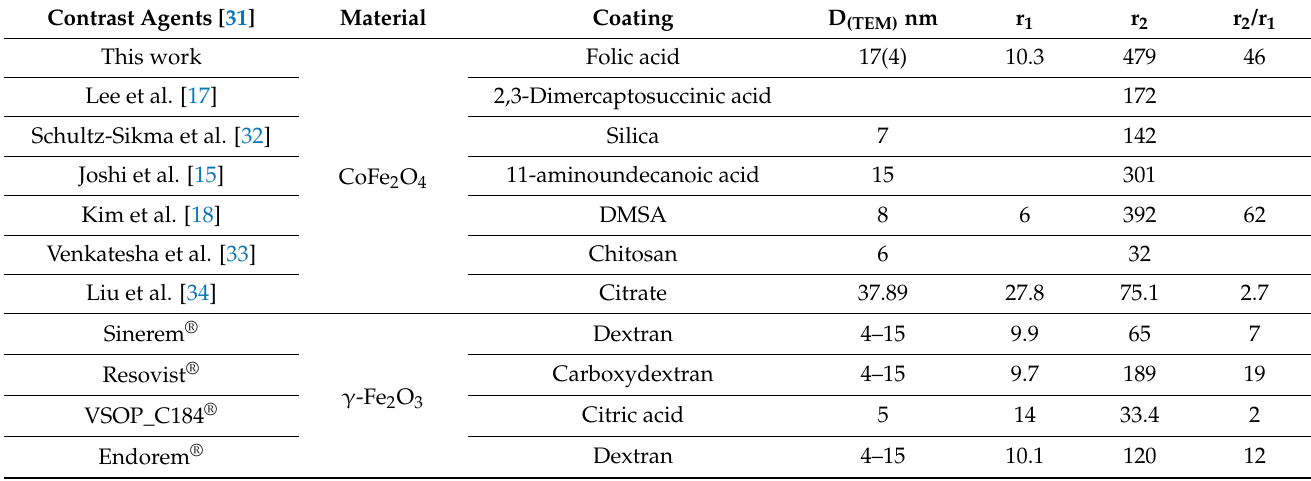
Figure 4. ( a ) T 1 and T 2 inverse measurements vs. cobalt and iron millimolar concentration. The slope of these curves corresponds to r 1 and r 2 relaxivities. ( b ) T 2 -weigthed magnetic resonance (MR) images of NP-FA in aqueous solution at various metal concentrations using a Varian 7T micro magnetic resonance imaging (MRI) scanner. Table 1. Relaxivity collection values found in the literature as a function of nanoparticle diameter and